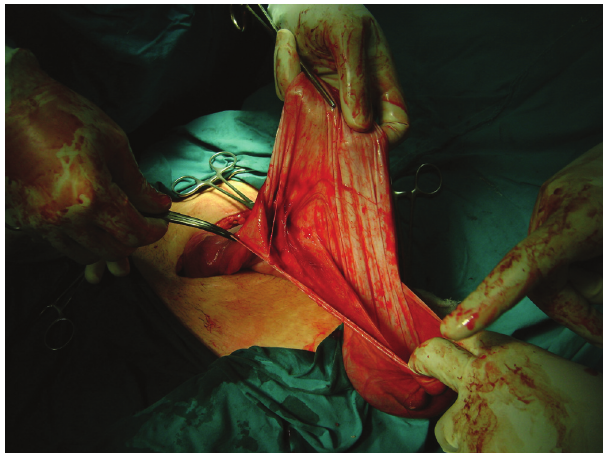
Figure 1. Appearance of the aspirated cyst wall after opening the broad ligament.